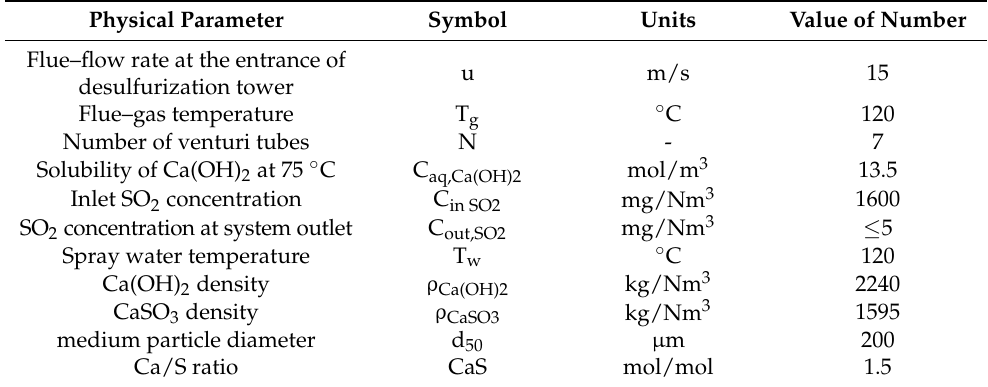
Table 2. Simulation